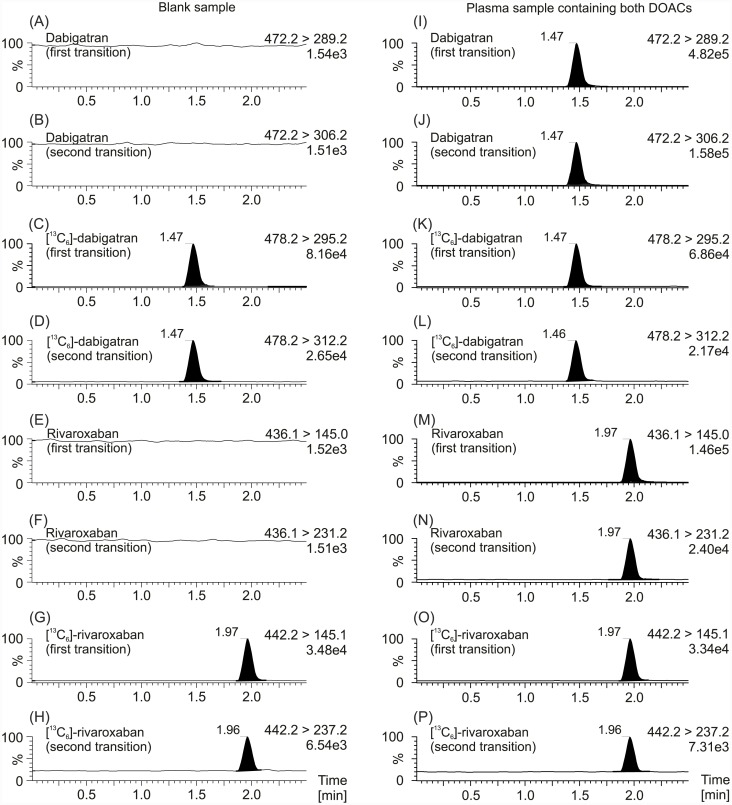
MRM chromatograms of plasma samples with and without DOACs.MRM chromatograms of a plasma sample without any DOACs are depicted on the left (A, B, E, F), as well as MRM chromatograms of a plasma sample containing both dabigatran and rivaroxaban are depicted on the right (I, J, M, N). MRM chromatograms of the internal standard [13C6]-dabigatran (C, D, K, L) concerning dabigatran, as well as the internal standard [13C6]-rivaroxaban (G, H, O, P) concerning rivaroxaban are also shown. The first mass transition which was used for quantification of the drug, as well as the second mass transition which was used for verification is plotted. Data were normalized to largest peak in the plots. An estimated peak height is shown in the plots below the transition remark.